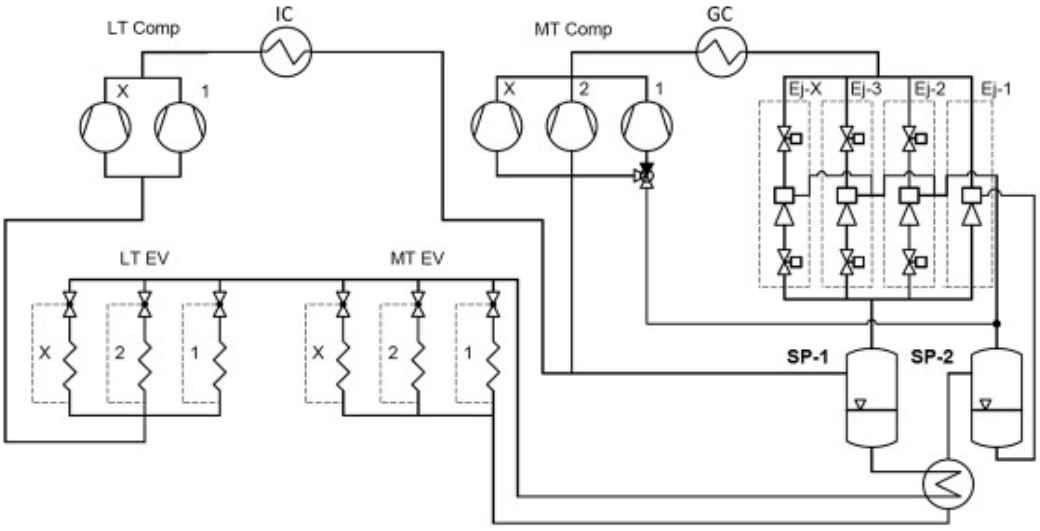
Figure 4. Schematic of a transcritical R744 booster supermarket refrigeration system outfitted with multi-ejector module and having MT overfed evaporators [10].